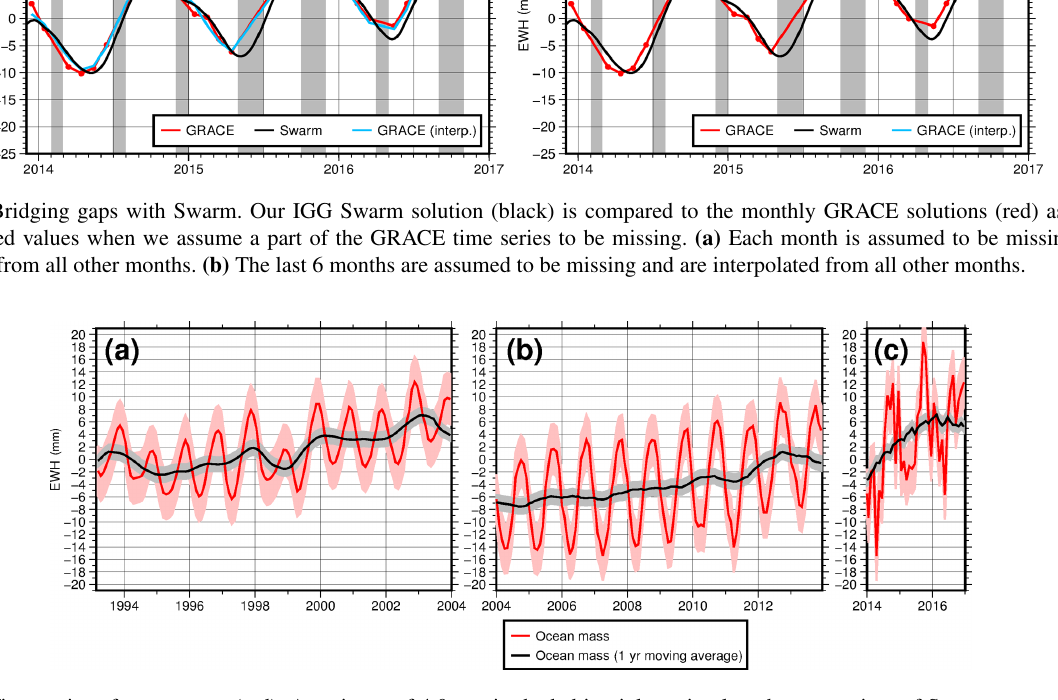
Figure 14. Time series of ocean mass (red). A variance of 4.0mm is shaded in pink to simulate the uncertainty of Swarm mass estimates. A moving average filter of 1 year is applied (black) and the resulting standard deviation is shown in gray. (a) Simulation of ocean mass (red) from Wenzel and Schröter (2007); 1993–2004. (b) Ocean mass from GRACE; 2004–2014. (c) Ocean mass from Swarm; 2014–2016. There is an offset between offset between panel (a) and panels (b) and (c) because of different mean